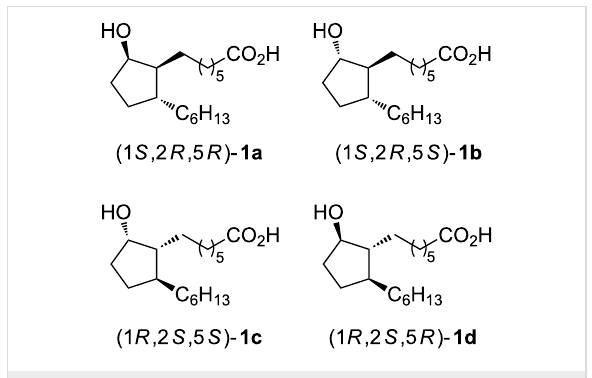
Figure 2: The structures of stereoisomers of rosaprostol ( 1